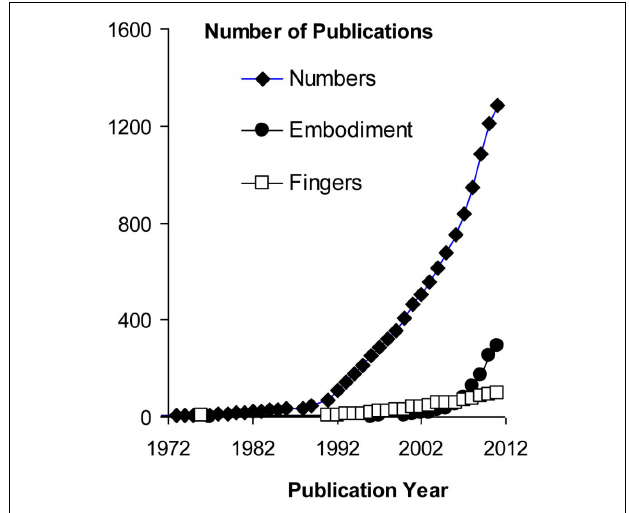
FIGURE 1 | Cumulative number of publications found inWeb of Knowledge on July 2, 2011, using as search terms (a)TS = (“embodied cognition”) orTS = (“embodied process*”); (b)TS = (“finger count*”); (c)TS = (“num* cognition” or “num* process*”).